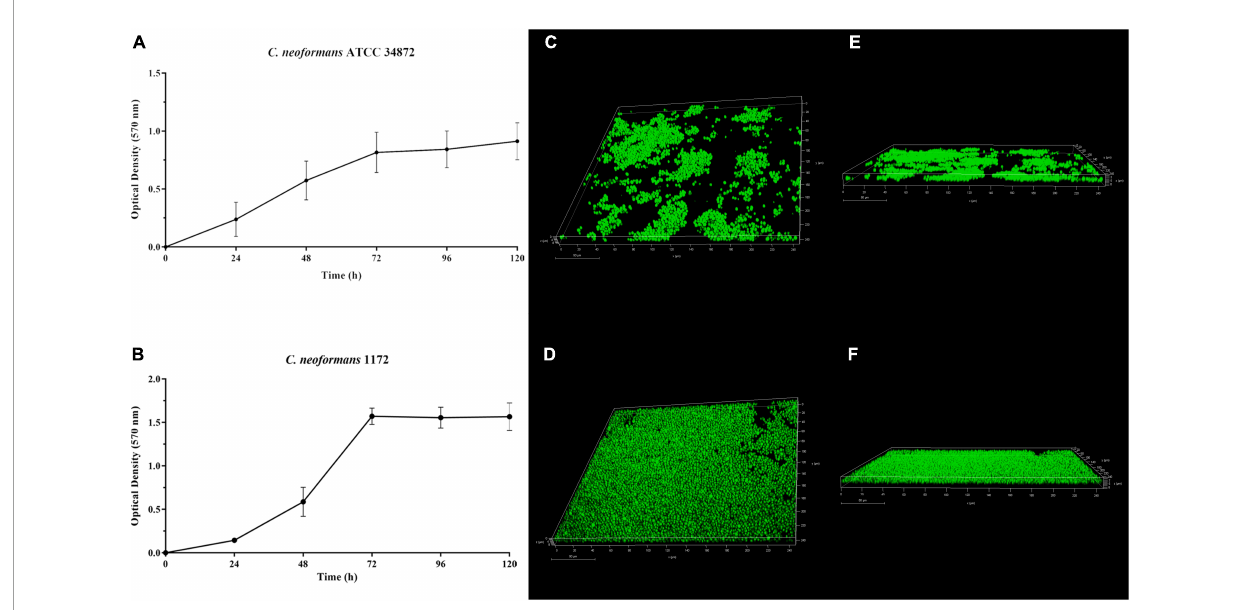
FIGURE5 Temporal development of Cryptococcus neoformans ATCC 34872 (A) and Cryptococcus neoformans 1172 (B) biofilms on polystyrene surface monitored by measuring the metabolic activity of sessile cells using MTT reduction (OD 570 nm ) assay. The values represent the mean ± SD of three independent experiments. Confocal laser scanning microscopy (CLSM) images of the C. neoformans ATCC 34872 (C,E) and C. neoformans 1172 (D,F) biofilms formed on glass surface after 72 h at 37 ◦ C. (C,D) Panoramic view of biofilm; (E,F) Three-dimensional biofilm reconstitution.